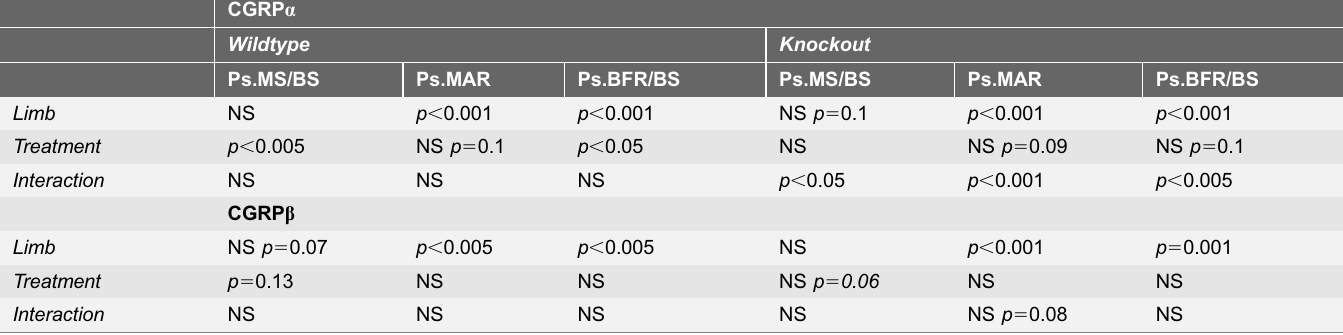
Table 2. Summary of two-way ANOVA results for load-induced periosteal bone formation in CGRP a and CGRP b wildtype and knockout mice.